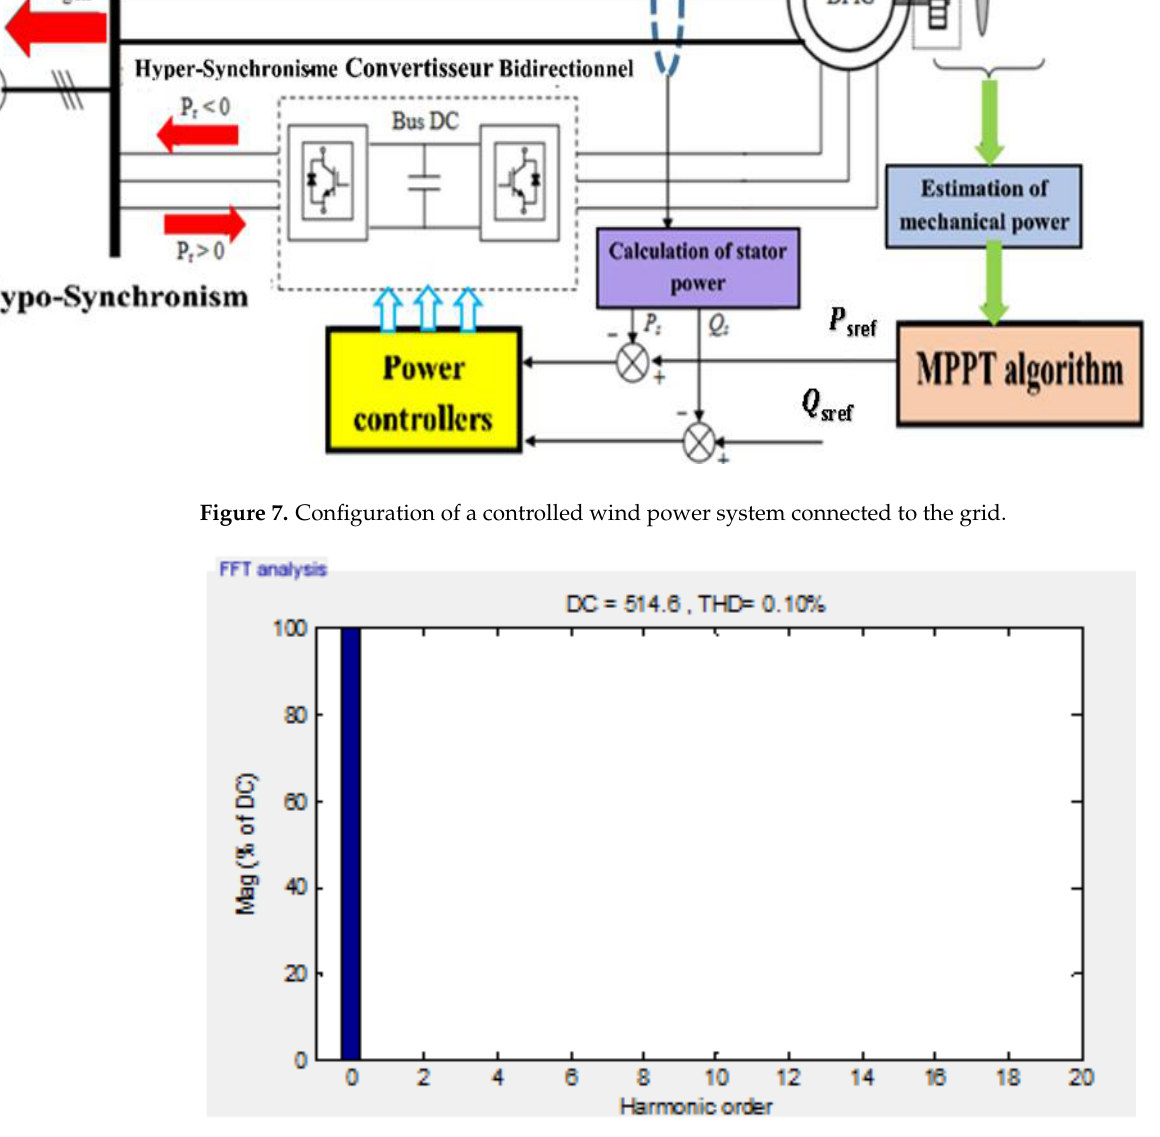
Figure 8. DC bus voltage control harmonics spectrum.